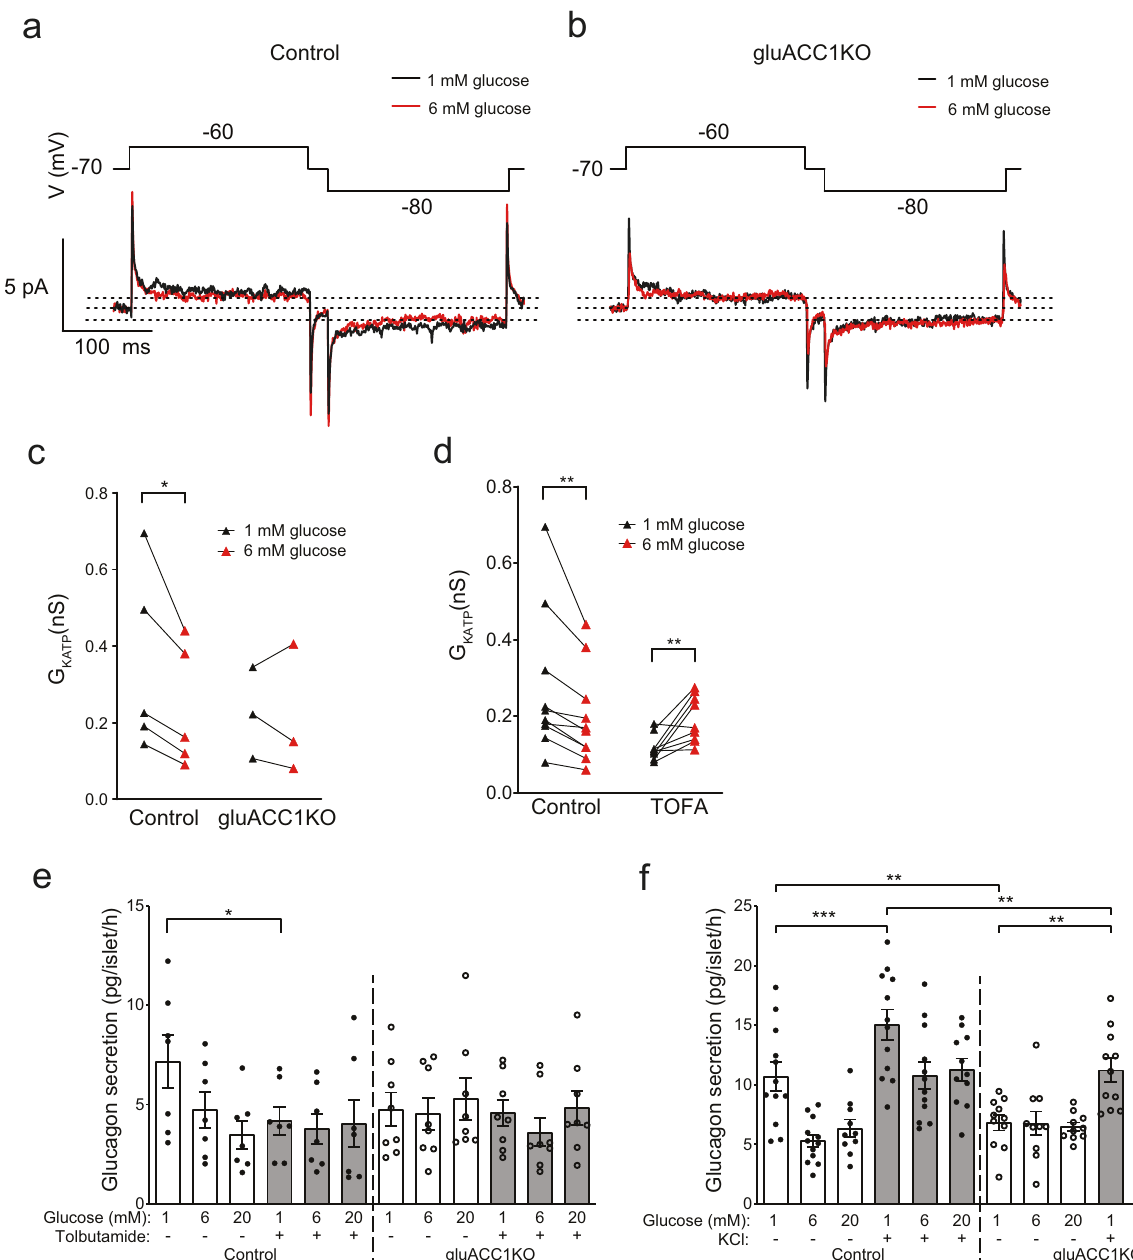
Fig. 4 Impaired glucose-regulation of K ATP -channels in gluACC1KO alpha-cells. a – c Electrophysiological recordings of K + currents triggered by ±10 mV excursions (200 ms) from − 70 mV in voltage-clamped primary control or gluACC1KO alpha-cells, in the presence of 1 or 6 mmol/l glucose (black or red traces/symbols, respectively). a , b Representative traces of K + currents. Dotted lines mark steady-state currents at − 60, − 70 and − 80 mV at 6 mmol/l glucose. c Summary data presented as K ATP channel conductance (GKATP(nS)) from individual cells from n = 3 – 5 independent preparations analysed by paired t -test. d Assessment of K ATP channel conductance (as described for a – c ) in primary alpha-cells treated with 0.02% DMSO vehicle (Control) or 25 mmol/l TOFA for 1 h prior to, and during, recordings, to inhibit ACC1 activity. Summary data presented as K ATP channel conductance (GK ATP (nS)) from n = 9 – 10 independent preparations analysed by paired t -test. e Pancreatic islets isolated from control (black circles) and gluACC1KO (white circles) mice were used to quantify glucagon secretion in response to the indicated glucose concentrations, combined with vehicle (white bars) or 200 mmol/l Tolbutamide treatment (grey bars) to inhibit K ATP channel activity. Data from n = 7 – 8 independent islet preparations were analysed by two-way ANOVA with Fisher ’ s LSD test. f Islet glucagon secretion assessed in response to the indicated glucose concentrations, combined with vehicle (white bars)